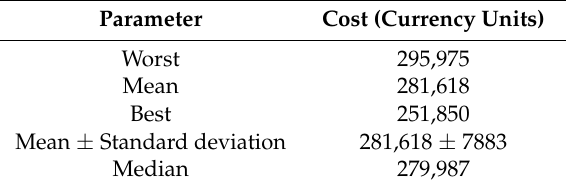
Table 3. Results of the cost of the FRM network using the genetic algorithm